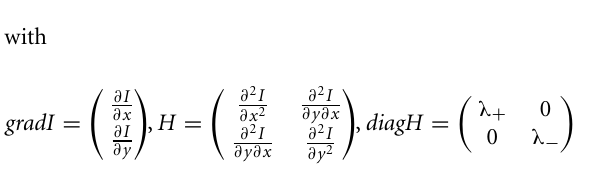
M) is the DNA ladder marker lane.The right-most lane corresponds to the positive control derived from PW12 rats. Ad, adrenal; Li, liver; Ov, ovary;Te, testis.The lane Nc represents the negative control. (B) Comparison of relative expression level of sex-steroidogenic enzymes and receptors at P1 and 12week. PD1 is set to be 100% for each gene. Abbreviations are, for example, P1 (postnatal day 1),W4 (4week), andW12 (12week). Modified from Kimoto et al.